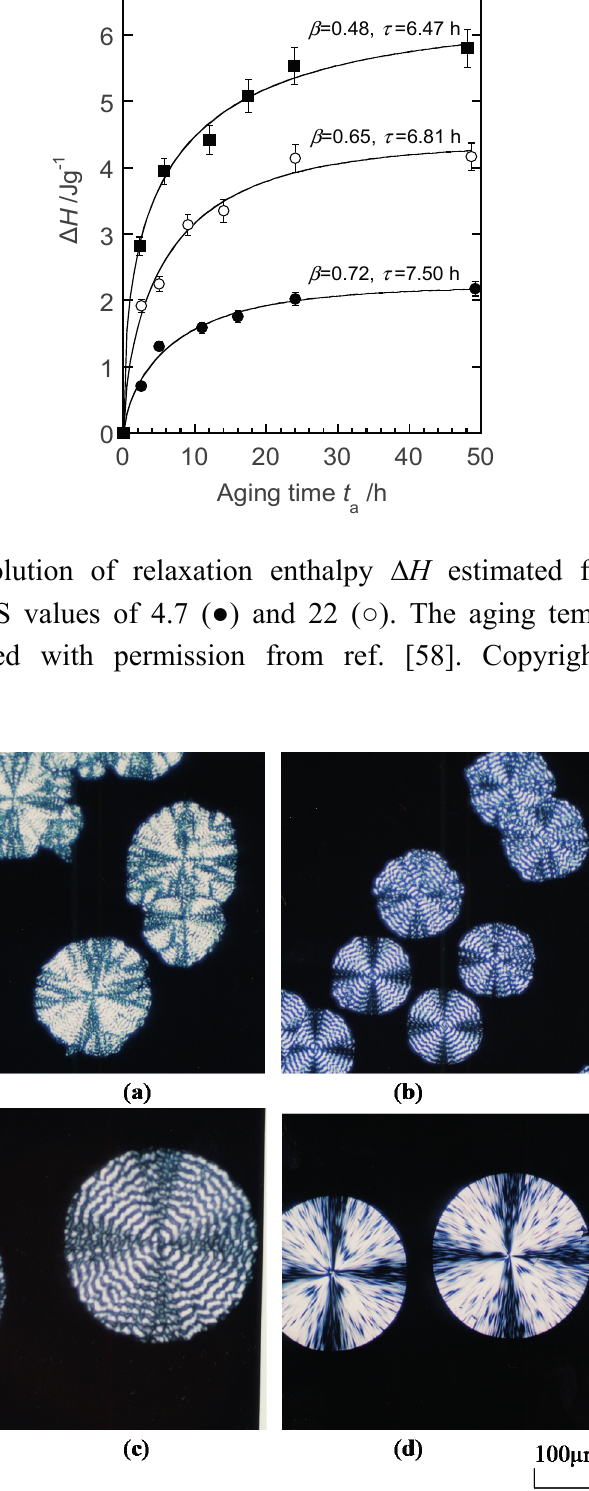
Figure 22. Polarized optical micrographs of typical spherulites observed for CA 2.15 - g -PLLAs and plain PLLAs: ( a ) MS = 22 at T ic = 107 °C and t = 4000 min; ( b ) MS = 58 at T ic = 119 °C and t = 365 min; ( c ) MS = 77 at T ic = 110 °C and t = 300 min; ( d ) PLLA at T ic = 130 °C and t = 30 min. T ic is the isothermal crystallization temperature and t is the elapsed time. Reproduced with permission from ref. [58]. Copyright 2004 American Chemical